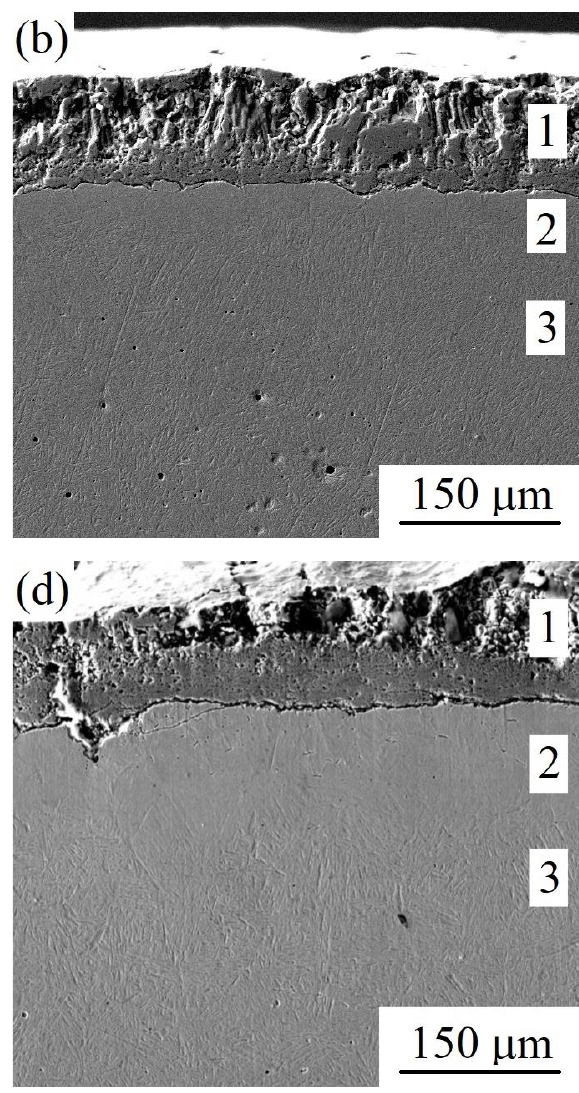
Figure 5. EDX nitrogen distributions in the nitrocarburzsed layer after cathodic PENC.